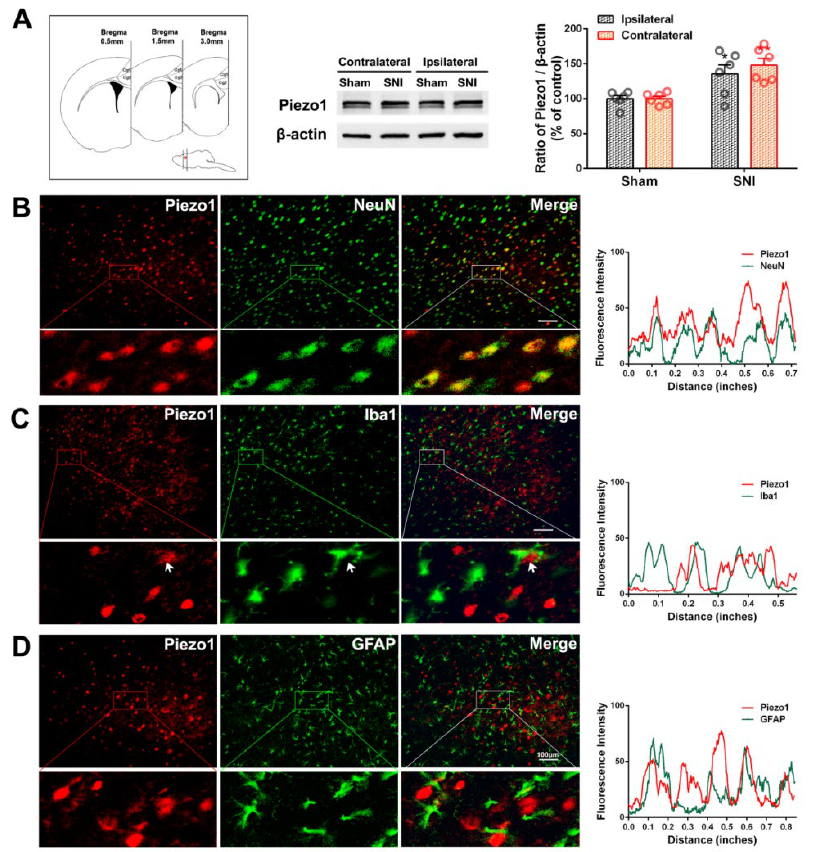
Figure 1. SNI induces Piezo1 overexpression in ACC neurons. ( A ) SNI-induced bilateral expression of Piezo1 in the ACC. Left, Cg1 and Cg2 tissues were used for Western blotting. Coronal dissection was performed 3.0–0.5 mm anterior to the Bregma. A representative Western blot of Piezo1 expression in the bilateral ACC is shown in the middle. The protein quantification results from Western blotting are shown on the right. Significant differences in Piezo1 expression were observed on both sides of the ACC 7 d after SNI. * p- value < 0.05, ** p- value < 0.01 versus the sham group (two-way ANOVA). ( B – D ) Representative double immunofluorescence staining showing the overlap (yellow) of Piezo1-IR (red) with neuronal marker NeuN (green), but not with microglial marker Iba1 (green) and astrocyte marker GFAP (green), 7 d after SNI. The arrowhead in ( C ) indicates Iba1-IR surrounding or partially overlapping Piezo1-IR. Scale bar = 50 μm. The fluorescence intensity curves for red and green signals in the boxed areas are shown on the right side for each group.